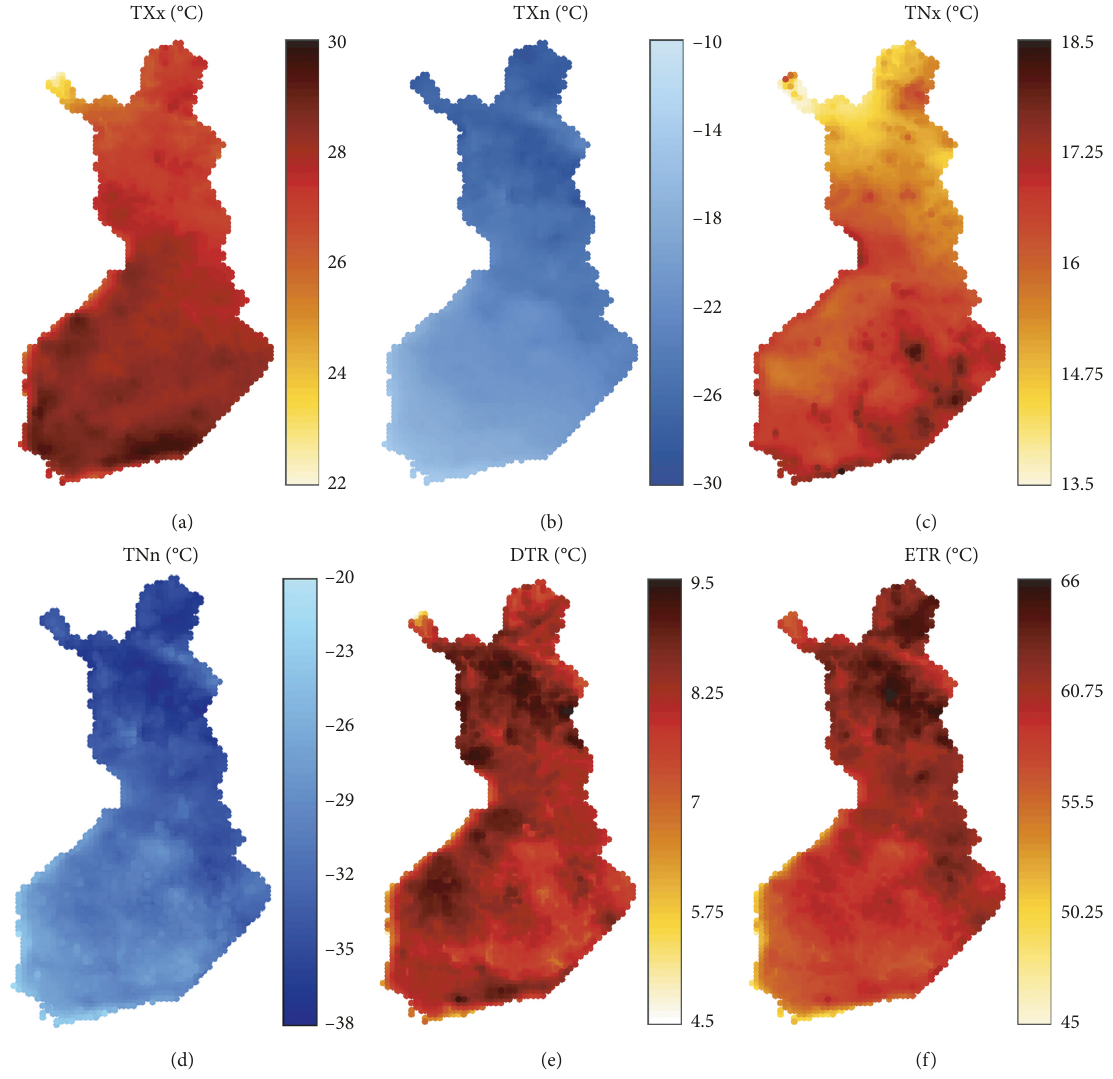
Figure 4: Spatial distribution maps of base values for (a) TXx, (b) TXn, (c) TNx, (d) TNn, (e) DTR, and (f) ETR in Finland during